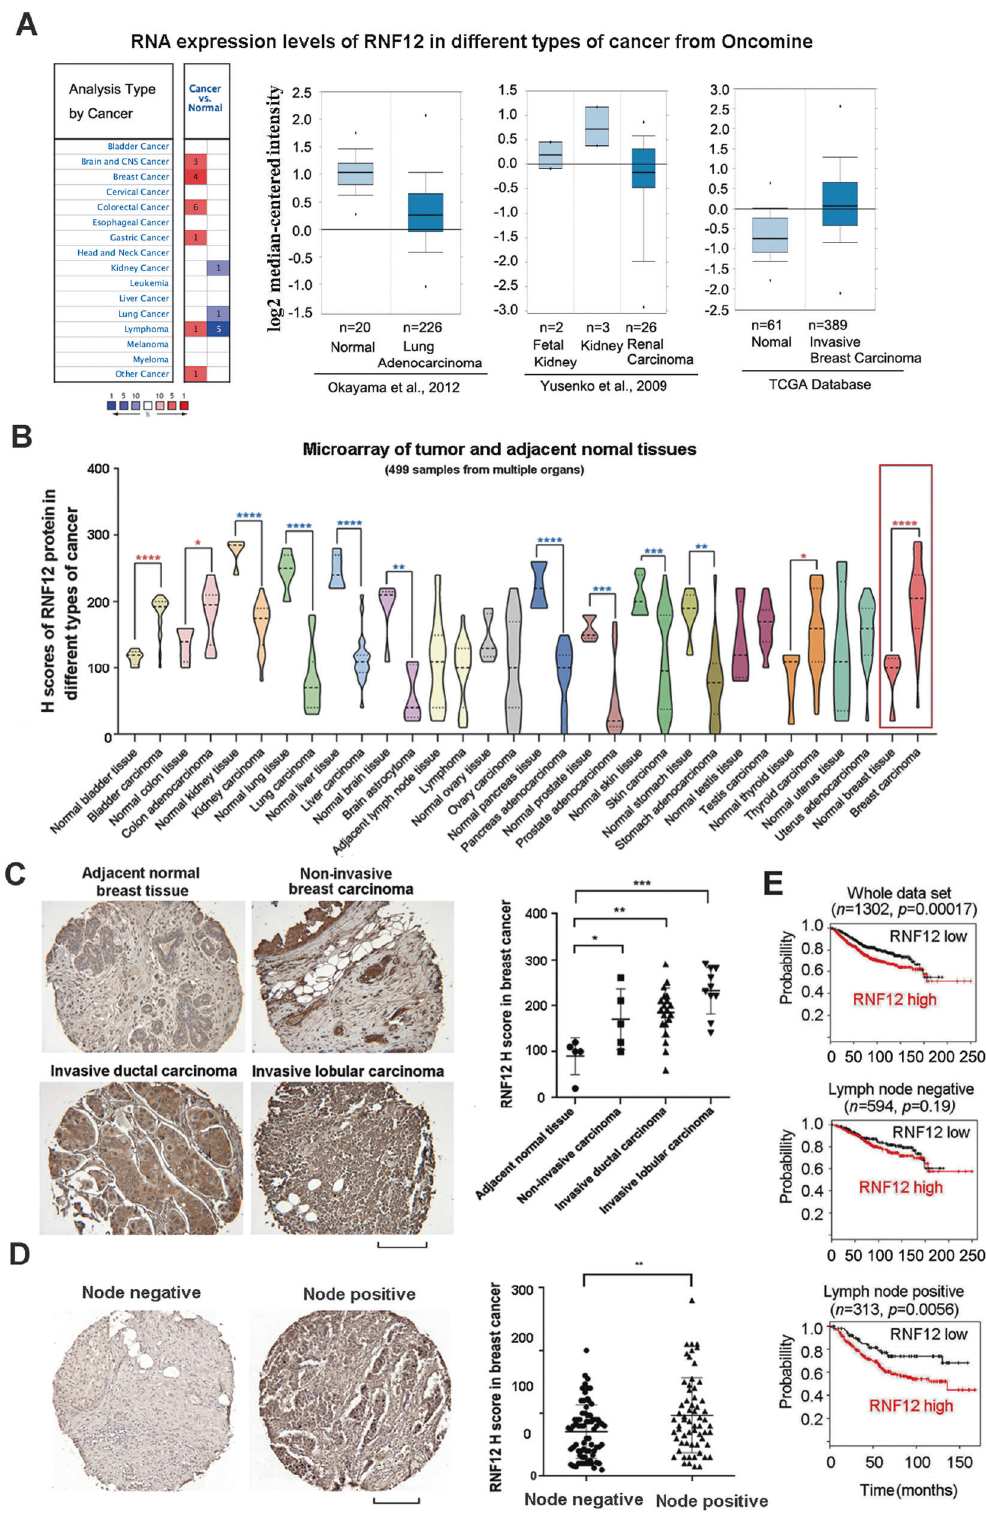
results obtained from cycloheximide (CHX) pulse/chase experi- ments demonstrated that the half-life of RNF12 mutant S215A was shorter than that of RNF12 WT (Fig. 3F), while the stability of RNF12 S347A/T349A was comparable to that of RNF12 WT protein (Fig. 3F). In addition, we found the half-life of endogenous RNF12